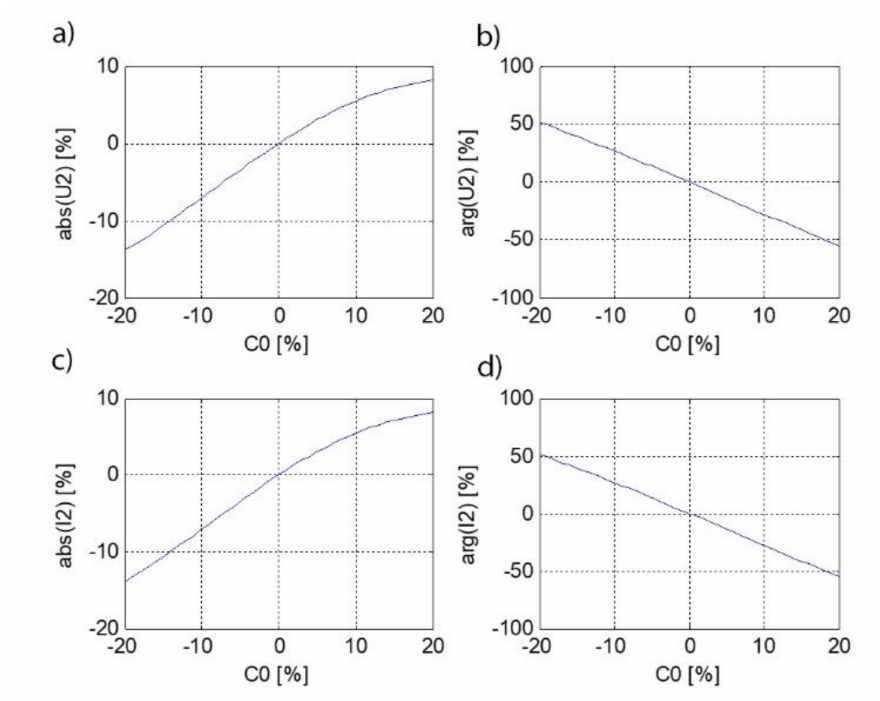
Figure 22. Changes of wave parameters depending on L 0 at f = 1 MHz; ( a ) U 2 voltage modulus, ( b ) U 2 argument, ( c ) I 2 modulus, ( d ) I 2